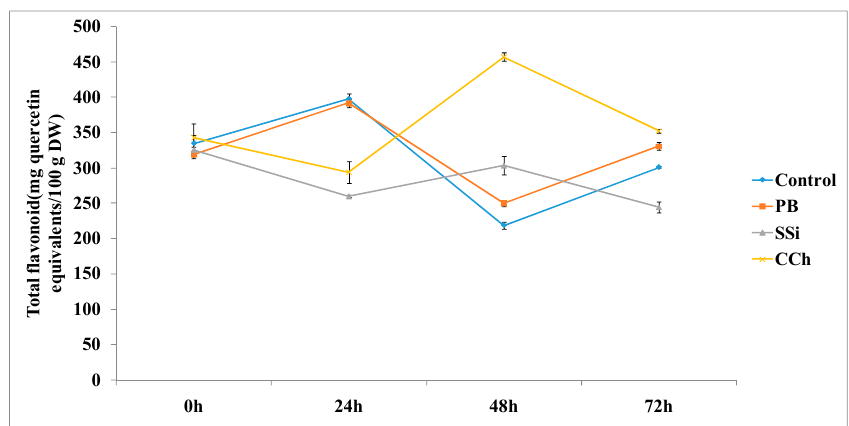
Figure 7. Time course of flavonoid content (mg quercetin equivalents/100 g DW) in extracts from table grape cv. Italia peel treated or not with PB, SSi and CCh. All the values are the means of three replicates ± SE.